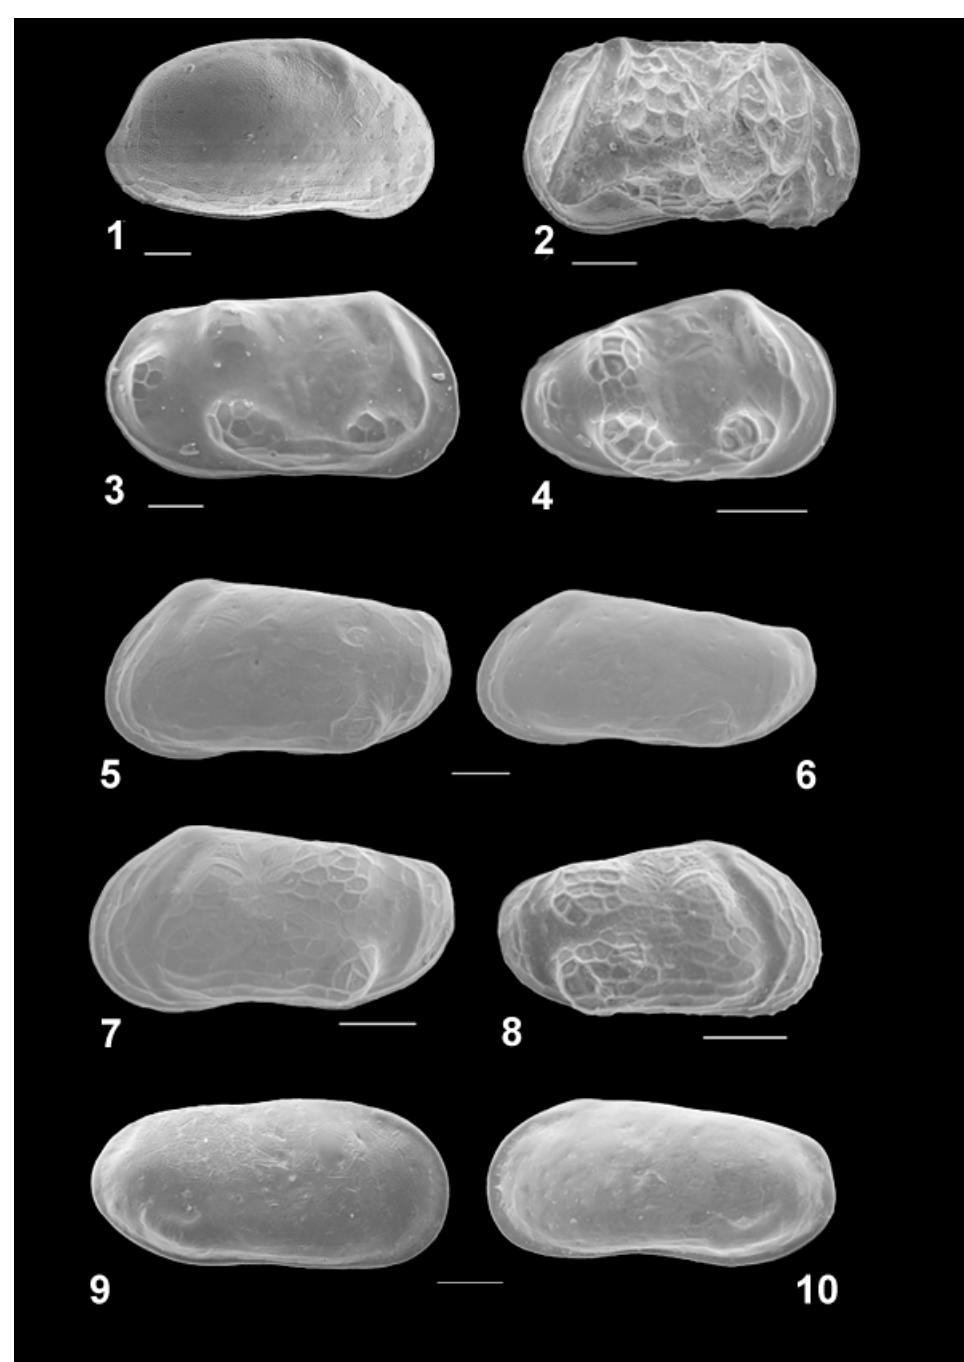
Figure 7. Ostracods of the studied Rybachya core. RV, right valve; LV, left valve; f, female; m, male; Ad, adult stages; juv, juvenile stages. Scale bar 100 µm. (1) Tyrrhenocythere amnicola donetziensis , RvAd; (2) Euxinocythere baquana , RVf; (3)–(4) Amnicythere ? quinquetuberculata , RVAd and RVjuv; (5)–(8) Amnicythere longa , LVf, LVm, LVA–1, and RVA–3; (9)–(10) Amnicythere cymbula , RVf and LVm.